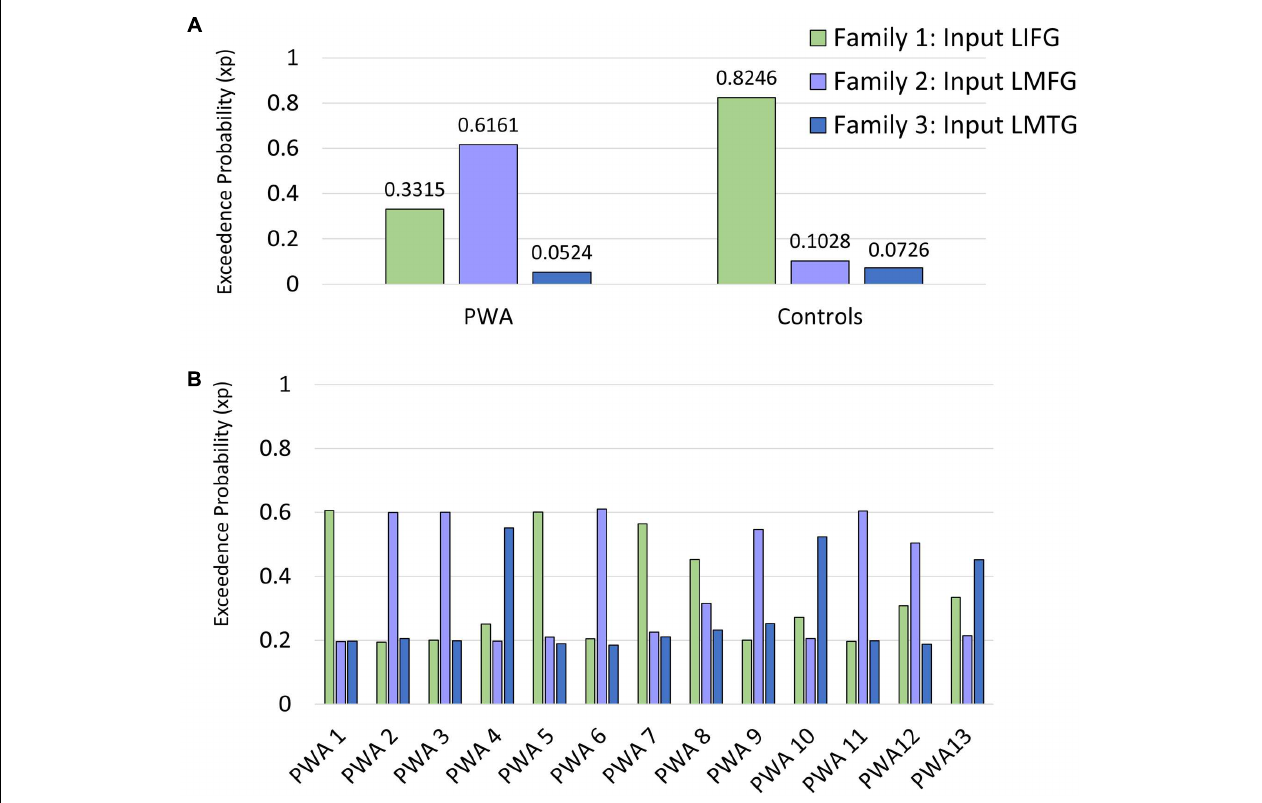
FIGURE 6 | Family wise BMS. (A) Group-level family wise BMS results. (B) Single-subject family wise BMS for the